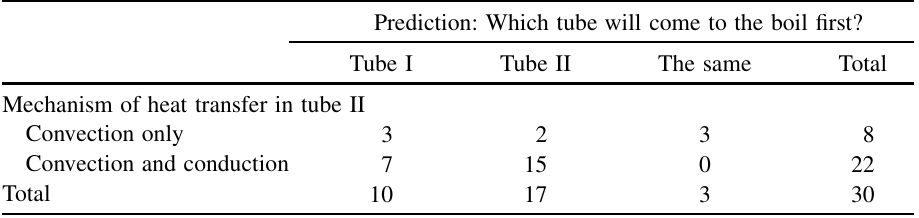
TABLE IV. Cross comparison between the participants’ predictions and the perceived mecha- nism of heat transmission. Prediction: Which tube will come to the boil first?